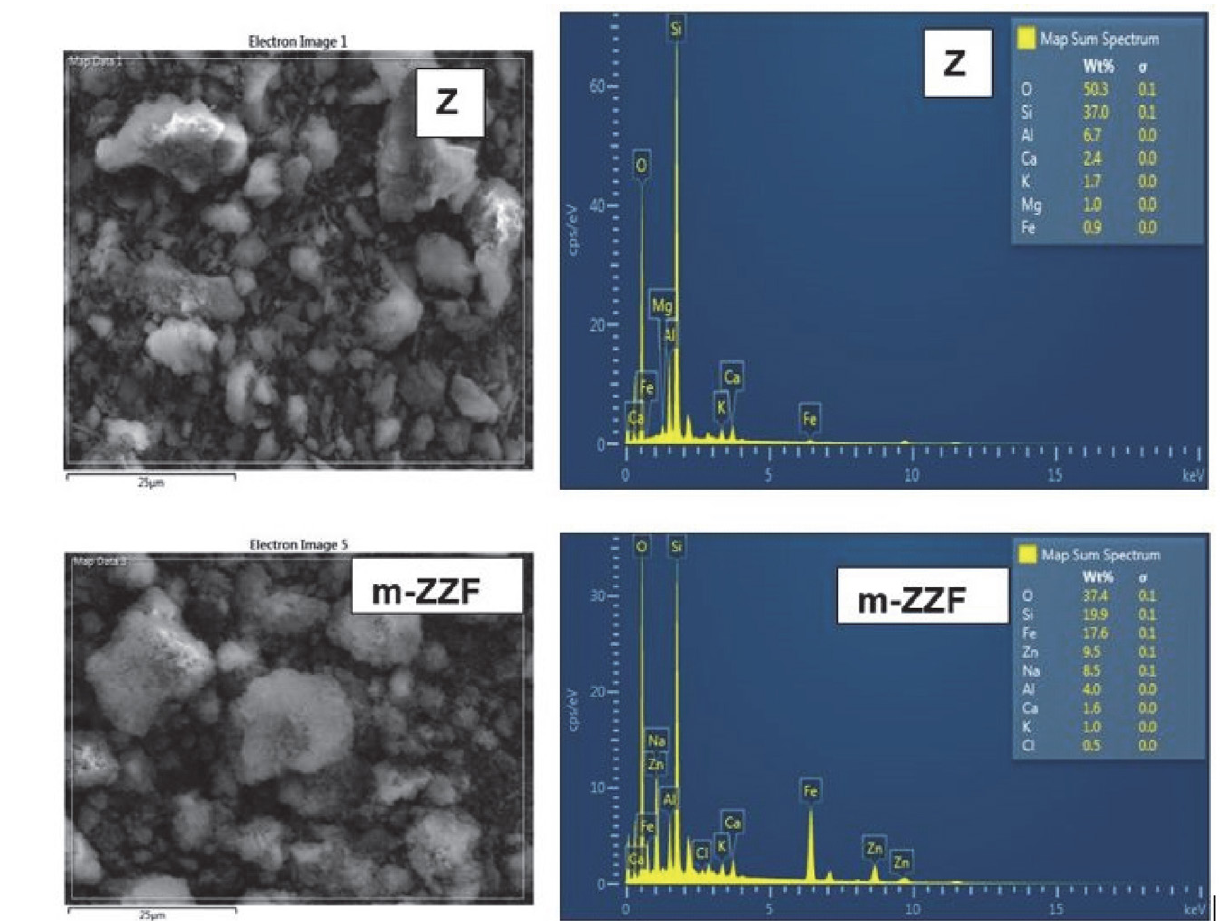
Fig. 2. SEM image and EDS results of zeolit and m-ZZF